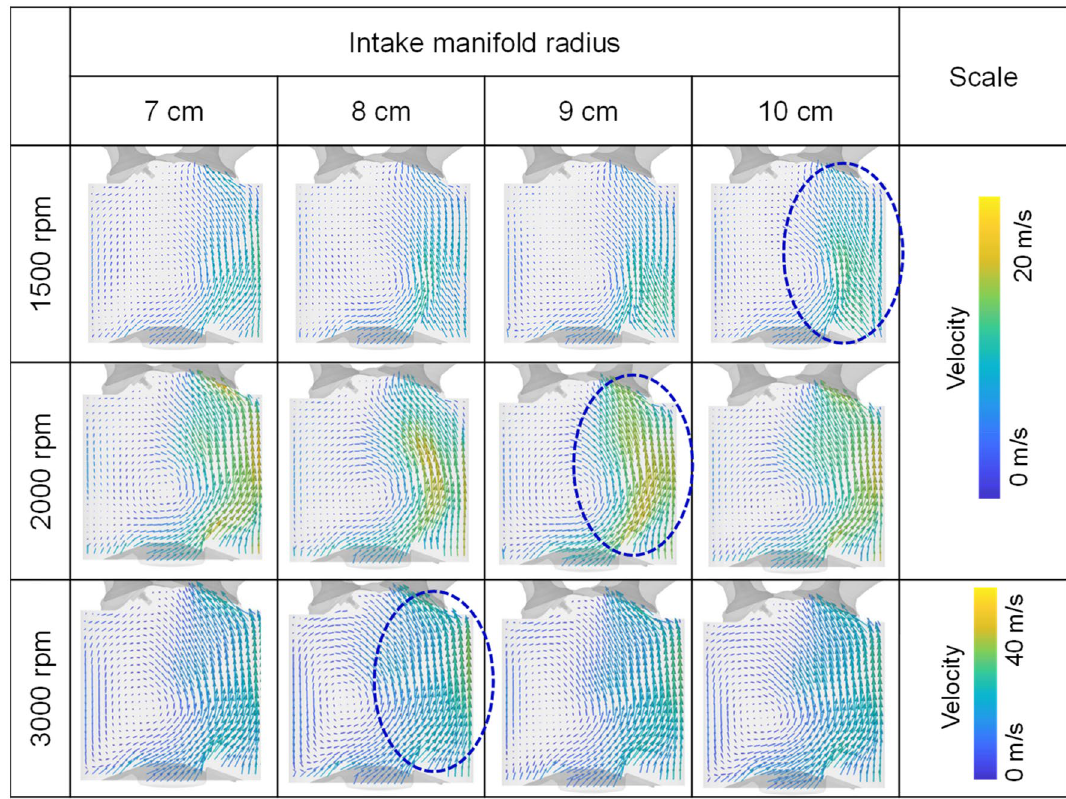
Figure 25. Velocity distribution for different intake manifold radius and engine speed at bTDC